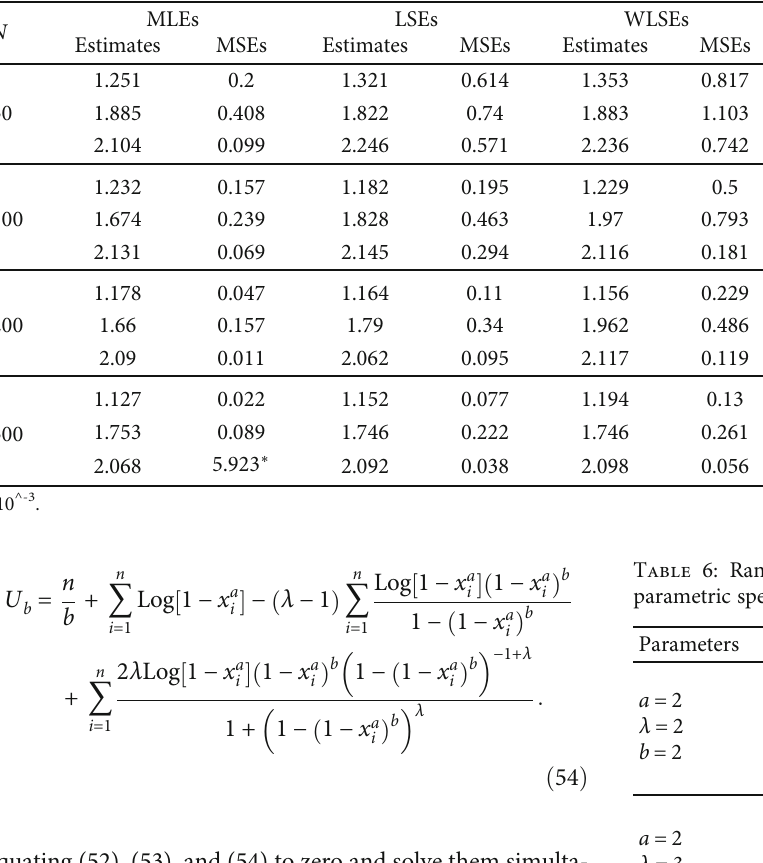
Table 5: Estimates and MSEs of parameters of TIIHLKw Distribution for the Set4 ( a = 1, λ = 2, b = 2